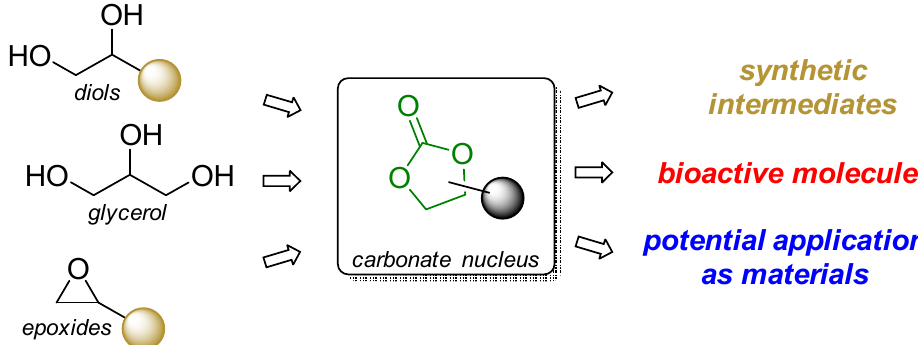
Figure 1. Versatility of five-membered cyclic carbonates.